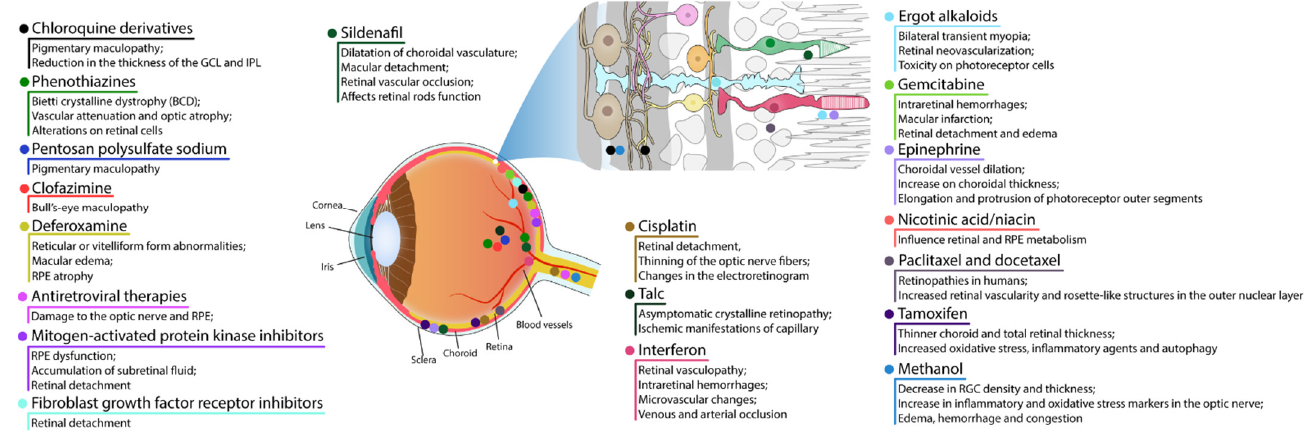
Figure 2. Schematic figure showing the areas affected by some drugs. Alterations in retinal vessels and RPE are represented in the eye whereas impact in retinal cell are showed in the retinal scheme.